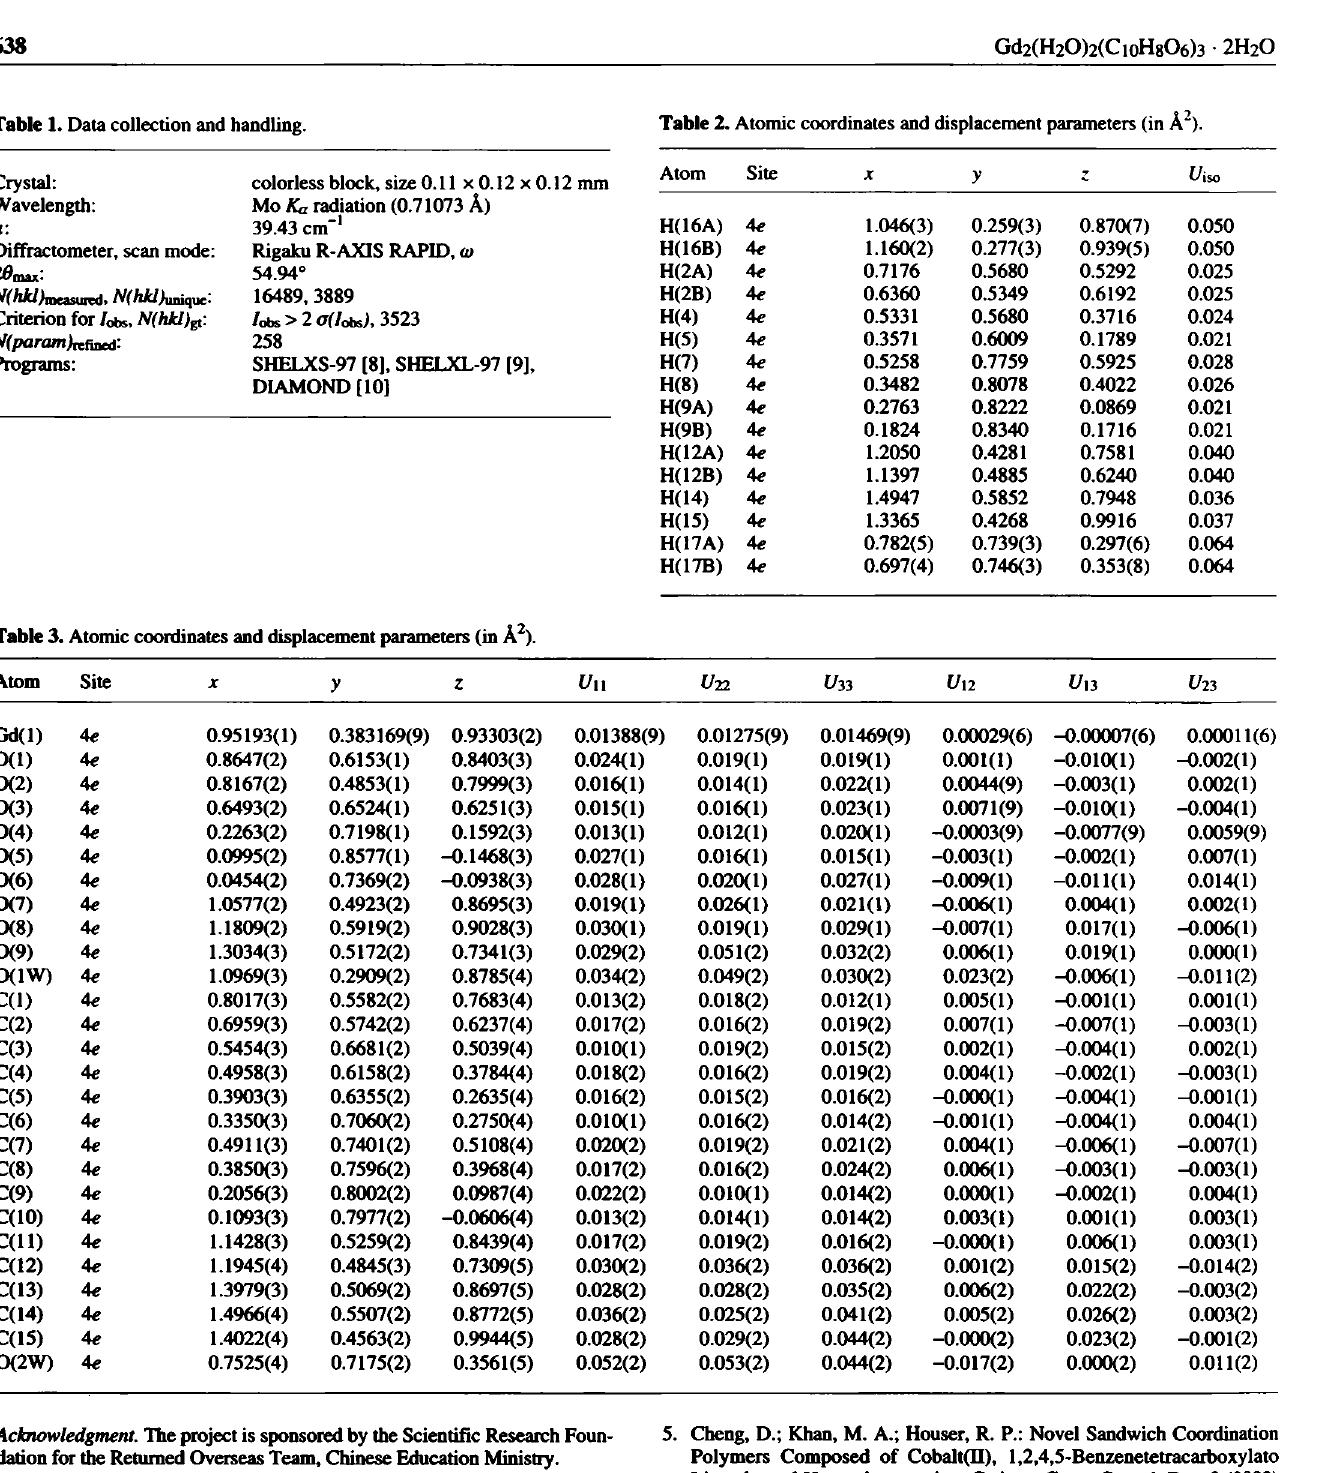
Table 1. Data collection and handling. Table 2. Atomic coordinates and displacement parameters (in À 2 ).